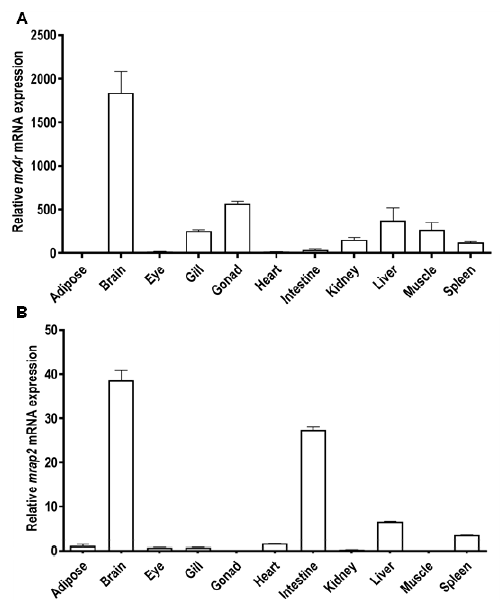
Figure 4. Tissue distribution patterns of snakehead mc4r ( A ) and mrap2 ( B ). Eleven tissues were studied in the present study. Results were expressed as relative expression levels and standardized by tub α 1-b gene. Error bars represented standard error of the mean (SEM) ( n = 6). Similarly, snakehead mrap2 was also widely distributed in these tissues with the highest expression in brain (Figure